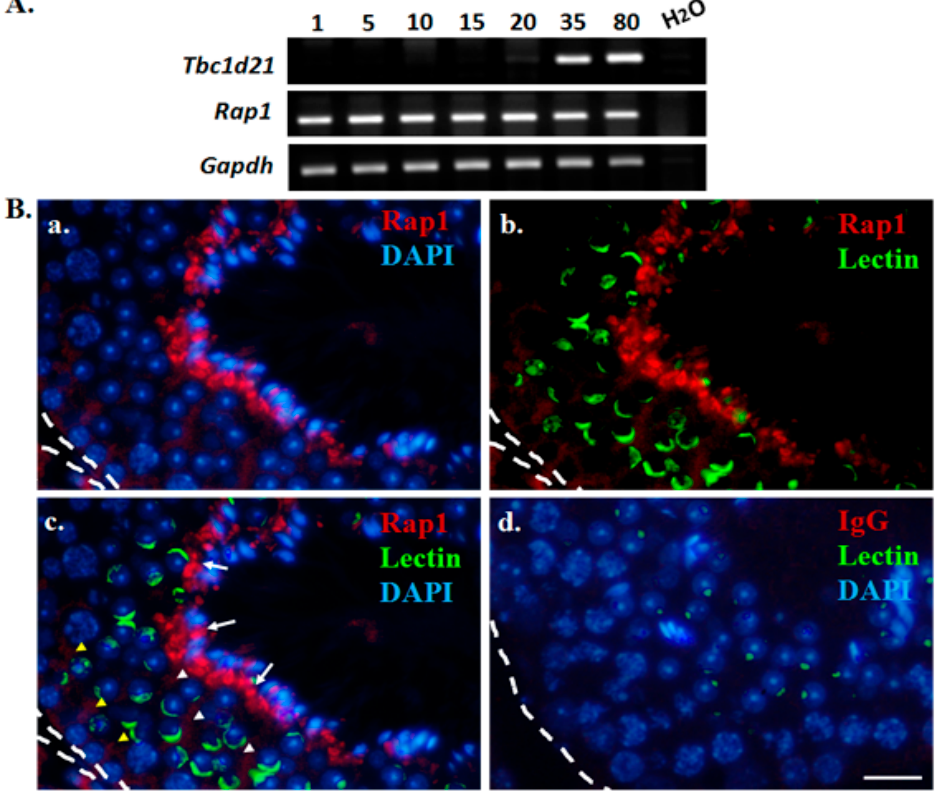
Figure 3. Expression patterns of Rap1 during murine spermatogenesis. ( A ) Expression patterns of Rap1 and Tbc1d21 transcripts in the mouse testes of different postnatal days, determined by RT-PCR. Gapdh was the loading control. ( B ) Localization of Rap1 in testicular sections of an adult (80 days old) mouse, as determined through an immunofluorescence (IF) assay. Anti-Rap1 ( a – c ) or mouse IgG ( d ) antibodies (red); acrosomal marker (green; b , c ); 4 ′ ,6-diamidino-2-phenylindole (DAPI) (blue; a , c , and d ); merging of Rap1 and DAPI ( a ); merging Rap1 and acrosomal marker ( b ); merging of Rap1, acrosomal marker, and DAPI ( c ); merging of mouse IgG control, acrosomal marker, and DAPI ( d ). Scale bar: 20 μ m. The discontinuous white line marks the edge of the seminiferous tubules within the murine testicular tissue. Yellow arrowheads: Rap1 signals in spermatogonia, spermatocytes, and round spermatids; White arrows: Rap1 signals around the heads of elongating spermatids.